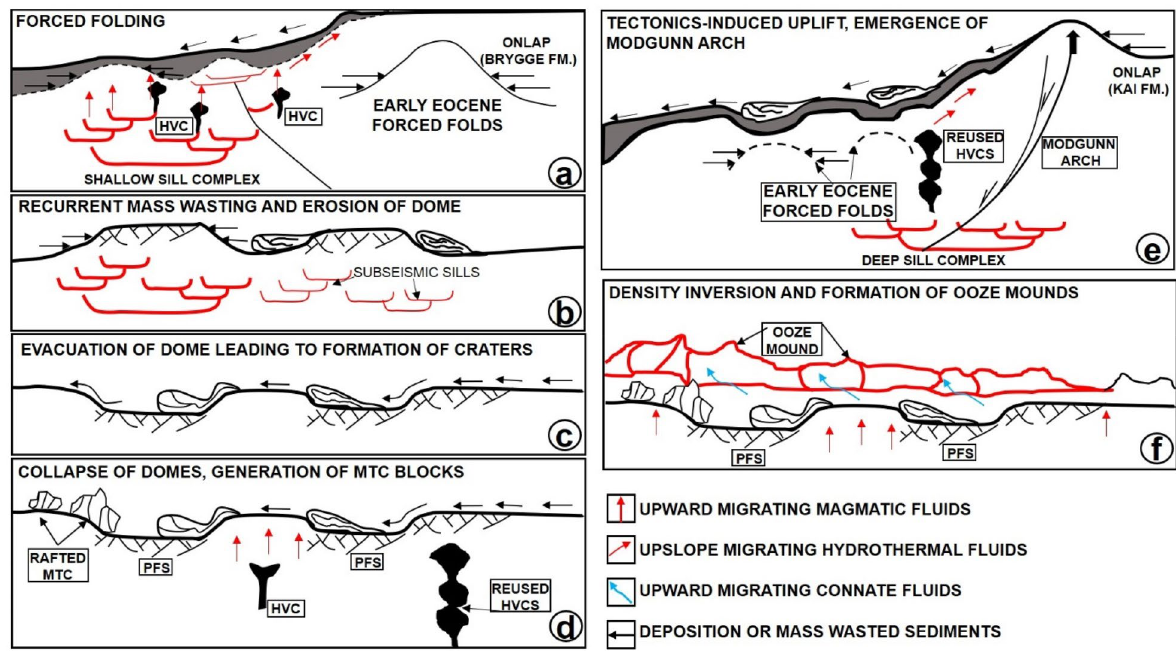
Figure 14. Conceptual model showing the evolution of craters in relation to magmatic emplacement, overburden uplift and mass wasting in the study area. Since the craters were preferentially formed on paleo- highs, their evolution is strongly tied to repeated erosion of these paleo-highs during recurrent mass wasting in the study Seismic interpretation. Four horizons were mapped and later tied to three of the wells in the study area (Figs. 1c, 2, 4 and 5). These horizons include: (a) H1, the top of the Brygge Formation (c) H2, a seismic reflection in the interior of the Kai Formation correlating with the top of the ooze interval within the Kai Formation (Riis et al. 2005), and (d) H3 and H4, which are part of the Naust Formation (Figs. 1c, 2 and 3). The mass-transport complex (MTC X) in the study area was defined using pre-existing tectonic stratigraphic information from previous workers 31,63 . On seismic profiles, the upper surface of MTC X is a rugged to ridged surface located above chaotic to moderately deformed seismic reflections of variable amplitude 64 . Conversely the basal shear zones of MTC X—comprising prominent m-size zones with a mélange of reworked strata and clasts, ripped blocks of seafloor material and faulted near-seafloor material—separate their internal, disrupted strata from relatively continuous deposits underneath 65,66 . To support the interpretation of the basal shear zone of MTC X and internal fill of the craters, variance maps were used to map striations and other basal kinematic indicators below MTC X. The variance attribute is a seismic time-derived attribute that measures the ‘dissimilarity’ between seismic traces and converts a volume of continuity into a volume of discontinuity, highlighting structural and stratigraphic boundaries 67 . On variance maps, MTC X is shown as an interval comprising chaotic reflections with well-defined basal shear zone upon which the failed masses of sediment were translated 64 . Variance maps are also good discriminator of lithology. Chaotic seismic facies (interpreted as debris flow deposits) are shown as intervals with low variance when compared to the well-bedded high- to medium-amplitude facies of underlying, undeformed strata. In addition, faults represent trace-to-trace variability and are shown as features with high variance coefficients. Furthermore, the interpretation of magmatic sills relied on identifying their typical seismic amplitude, geometries, and lateral continuity within the host-rock strata. The magmatic sills are characterized by their abrupt, localized brightening of positive-amplitude reflections with partial or complete loops of ‘peak- trough-peak’ reflections that are similar to the seafloor reflection 68 . As magmatic sills have greater densities and seismic velocities when compared to their surrounding strata, these are responsible for high acoustic-impedance contrasts at the sill-host rock contacts 69 . One‑dimensional (1‑D) estimates of magma‑related uplift In addition to the workflow for the seismic interpretation, we computed one-dimensional (1-D) models based on sonic (p-wave velocity) and gamma-ray data from wireline logs to obtain an overview of net erosion and uplift in the study area (Figure A1). Magma-related uplift was estimated using a normal compaction (representing no uplift) or reference velocity-depth trend (see blue line in Figure A1b). The red line above this latter is a velocity- depth trend of an area that has undergone uplift and erosion. Since eroded rocks are still compacted to a similar degree to what they were at their deepest burial point, the red line therefore plots higher than the blue reference trend (Figure A1b). The difference in depth between the reference trend and the eroded rock trend corresponds to the vertical difference between present day burial depth and the maximum burial depth 70 . The reference trend line used in this work was developed by 70 based on a simplified linear velocity-depth trend. The trend line is expressed as Z = 1.76 Vp –2600, where Z is depth in meters and Vp is the p-wave velocity